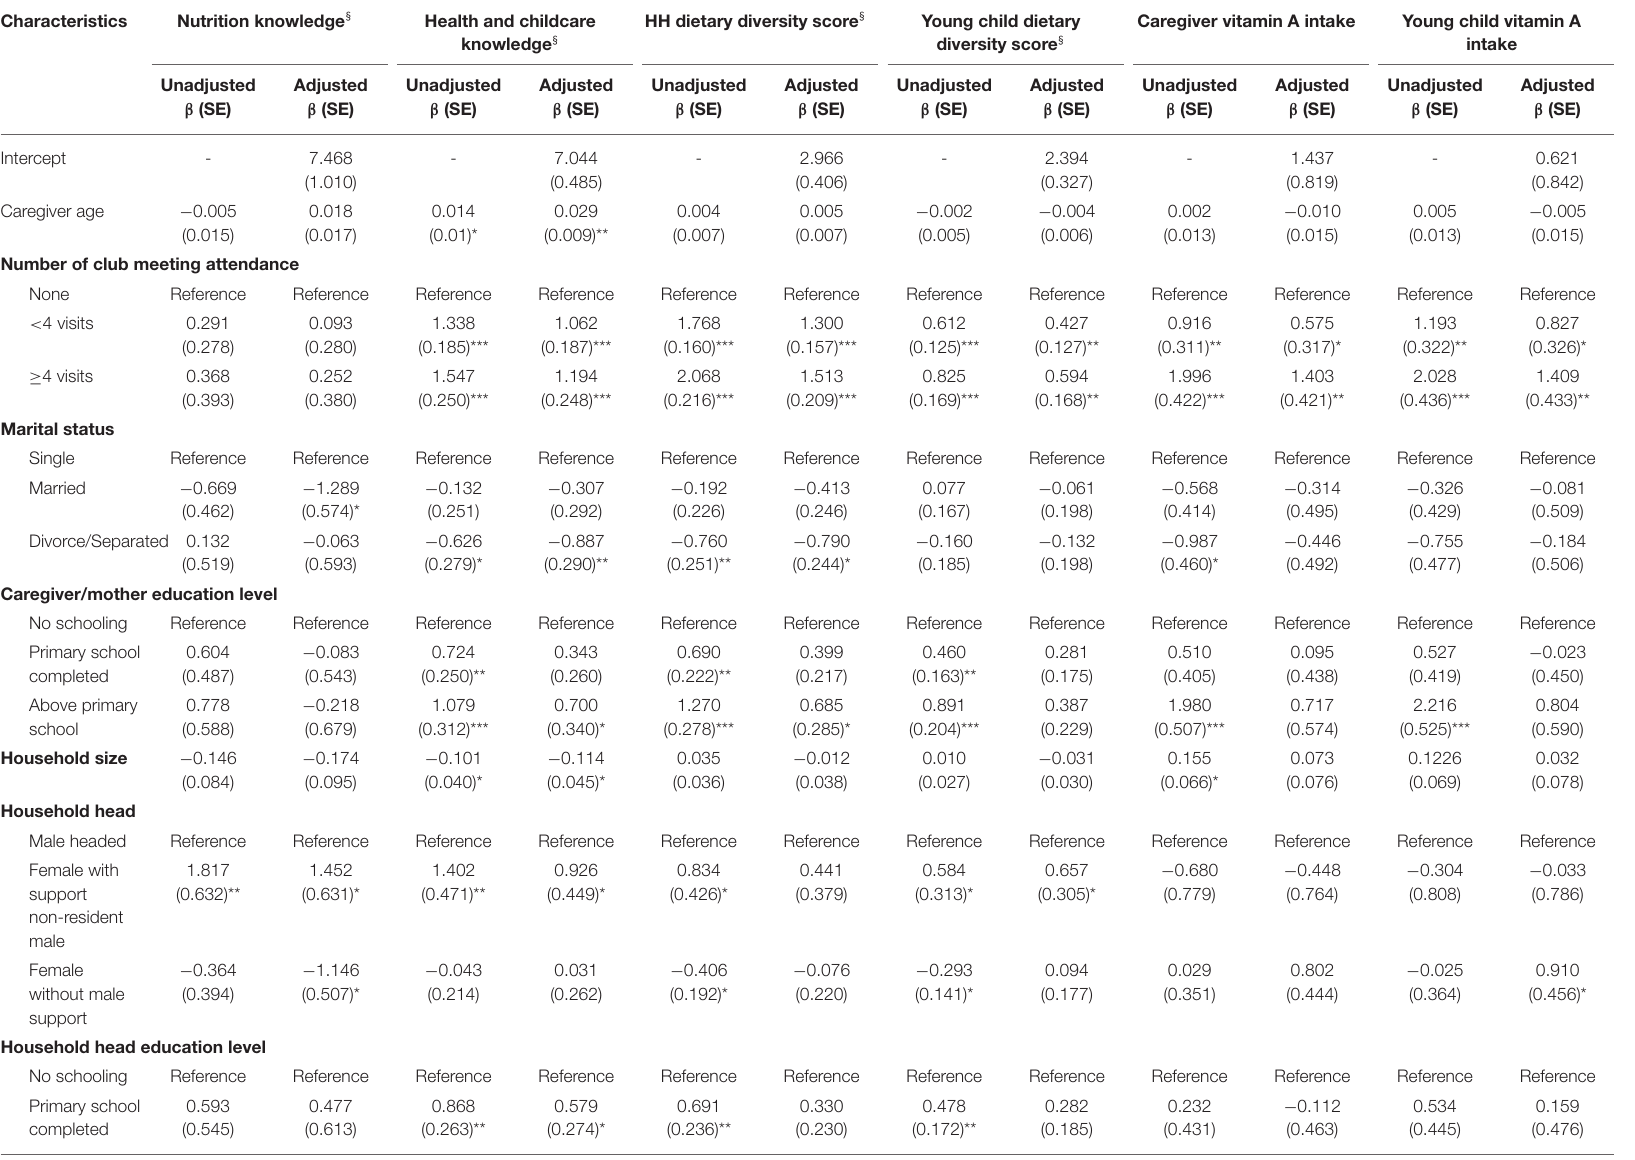
TABLE 3 | Effect of mother club participation on knowledge and practices among caregivers in rural Tanzania, adjusted for covariates.